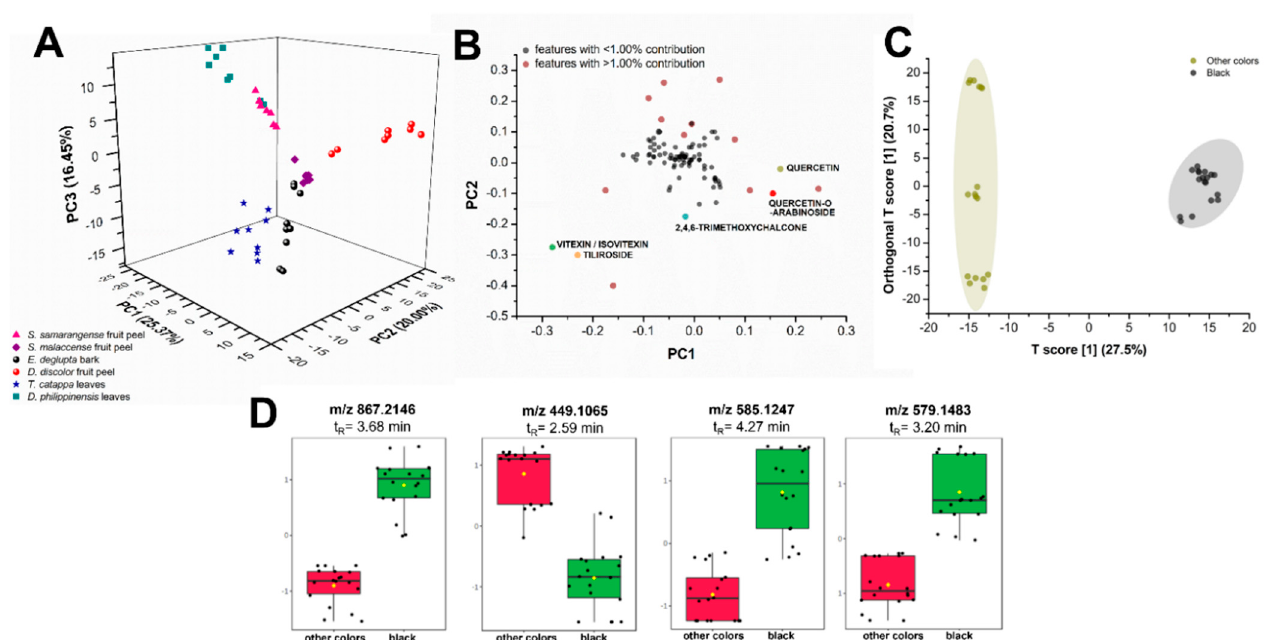
Figure 8. Comparative statistical analyses of metabolite profiles of plant biowaste sources. Unsupervised principal component analysis (PCA) ( A ) with its log-transformed loadings plot ( B ) and supervised OPLS-DA ( C ) show distinct separation between samples according to metabolite constituents and their produced color upon reaction with FeSO 4 mordant. Putatively identified flavonoids (colored data points) were among the heavily contributing features ( B ) to the dispersion of samples in the PCA scores plot. Samples that produce the black color such as extracts from E. deglupta bark, D. philippinensis peel, and T. catappa leaves show the upregulation of some polyphenols ( D ) such as m/z 867.2146 (epicatechin), m/z 579.1483 (procyanidin B2), and m/z 585.1257 (vitexin-2”-O-gallate).